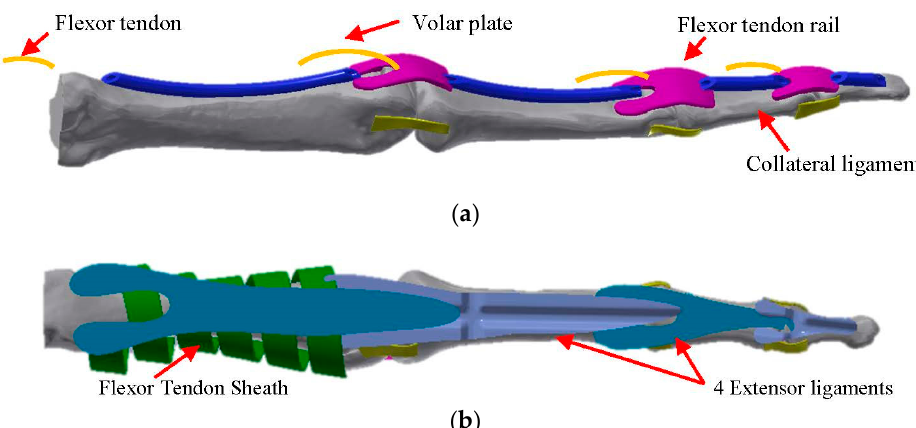
Figure 3. ( a ) Finger flexor tendon route and joins (two side collateral ligaments and volar plate). ( b ) Finger extensor tendons. Three-dimensional model of the prosthetic index finger assembly.